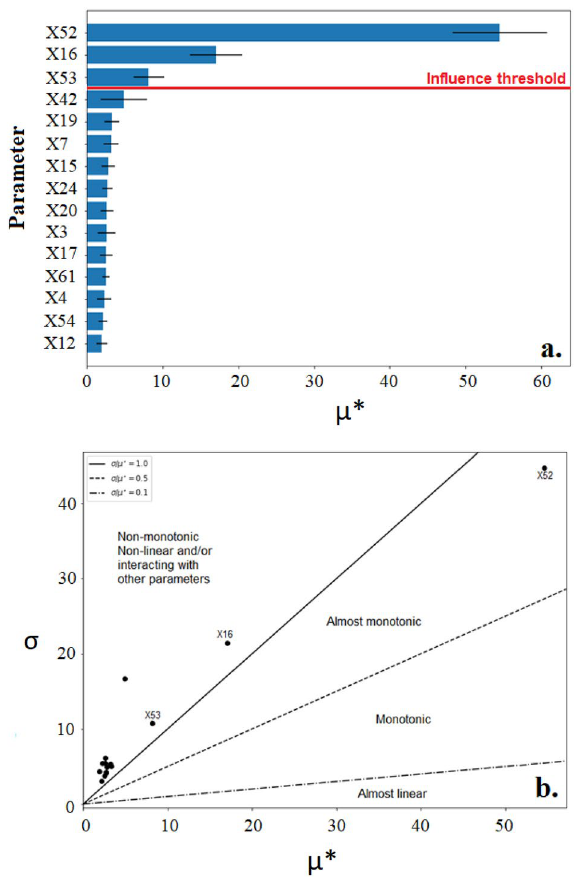
Figure 2. The 15 parameters of greatest influence on the BOD output as demonstrated by the MoM displayed by ( a ) A horizontal bar chart with influence threshold 0.1 and ( b ) a Morris plot